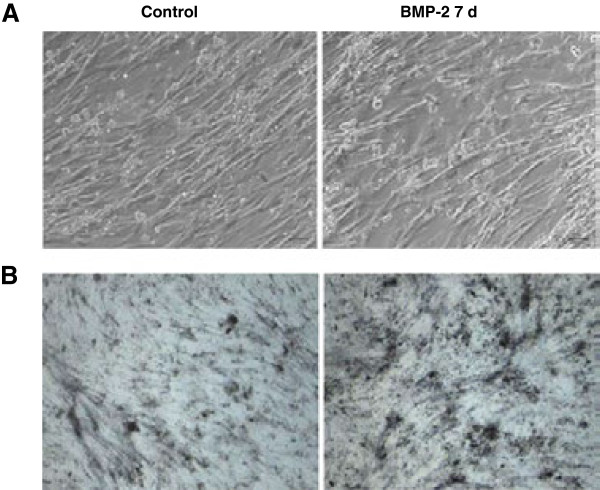
rhBMP-2-induced BMSC osteogenic differentiation. (A) Cell morphology of BMSCs without or with rhBMP-2 induction (labeled as control and BMP-2, respectively). The magnification is 100X. (B) Alkaline phosphatase staining was used to determine the status of osteogenic differentiation of BMSCs, without or with treatment with rhBMP-2. The image magnification is 100X.